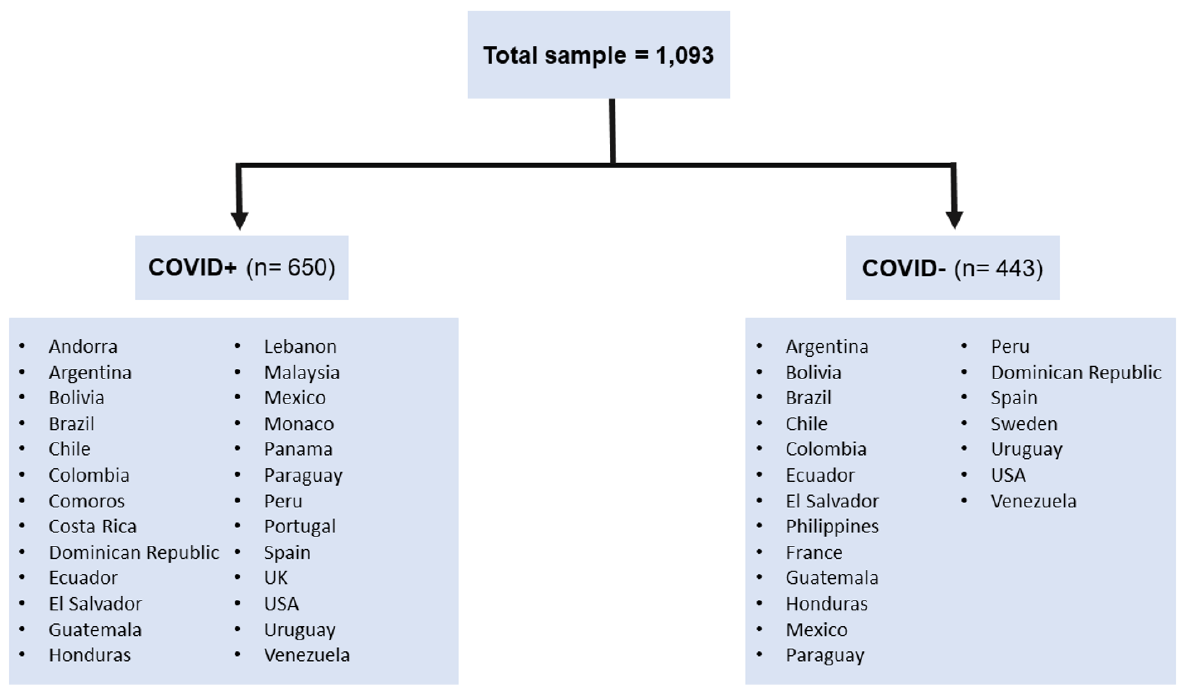
Figure 1. Countries included in the sample. Table 1. Sociodemographic characteristics of the study cohort (N = 1,093).